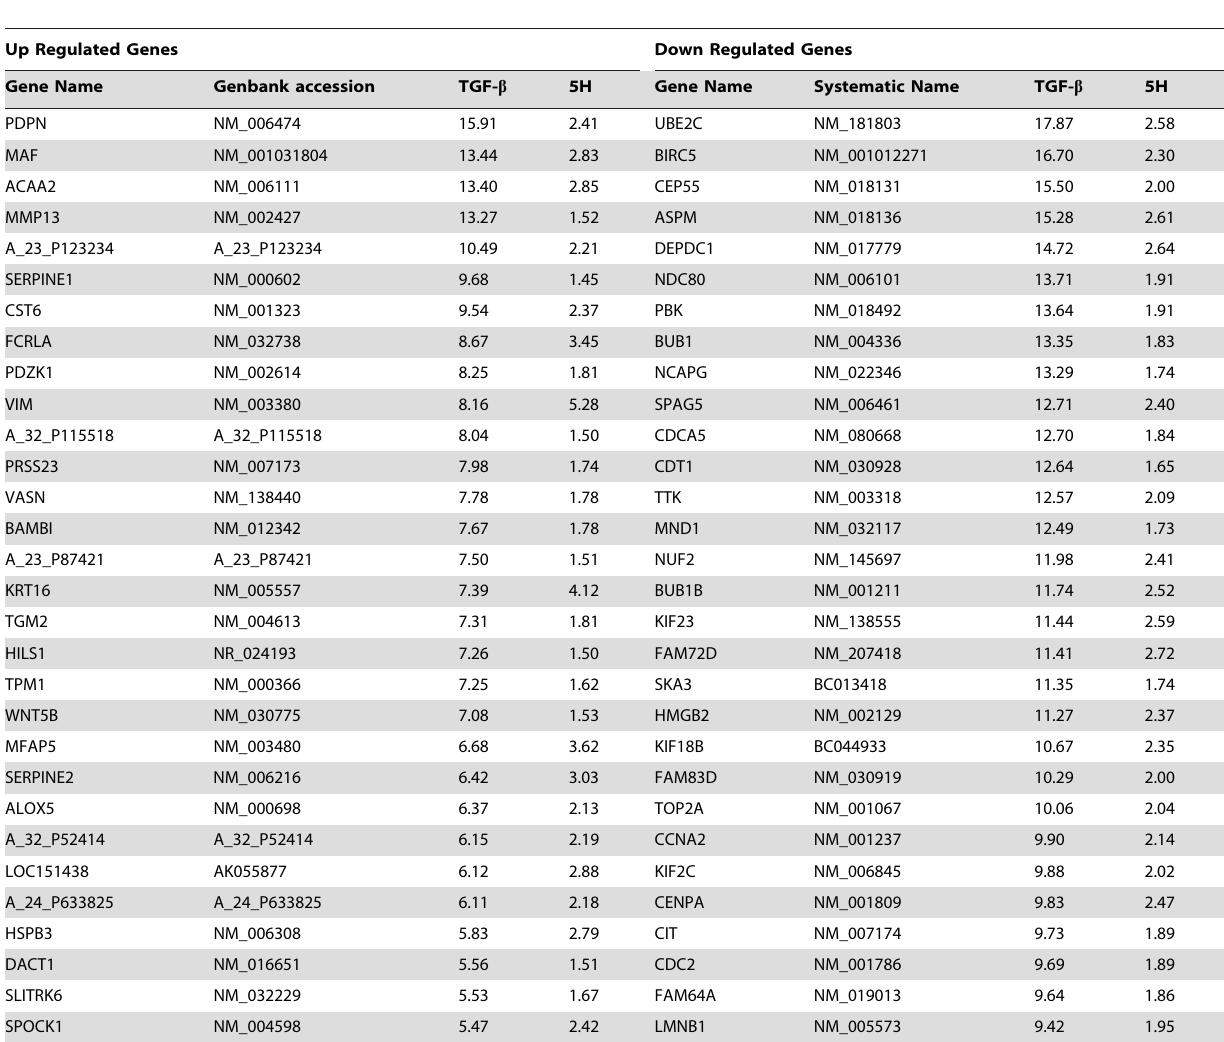
Table 4. List of top 30 commonly regulated genes showing Up or Down regulation by TGF- b and areca nut treatment on HaCaT